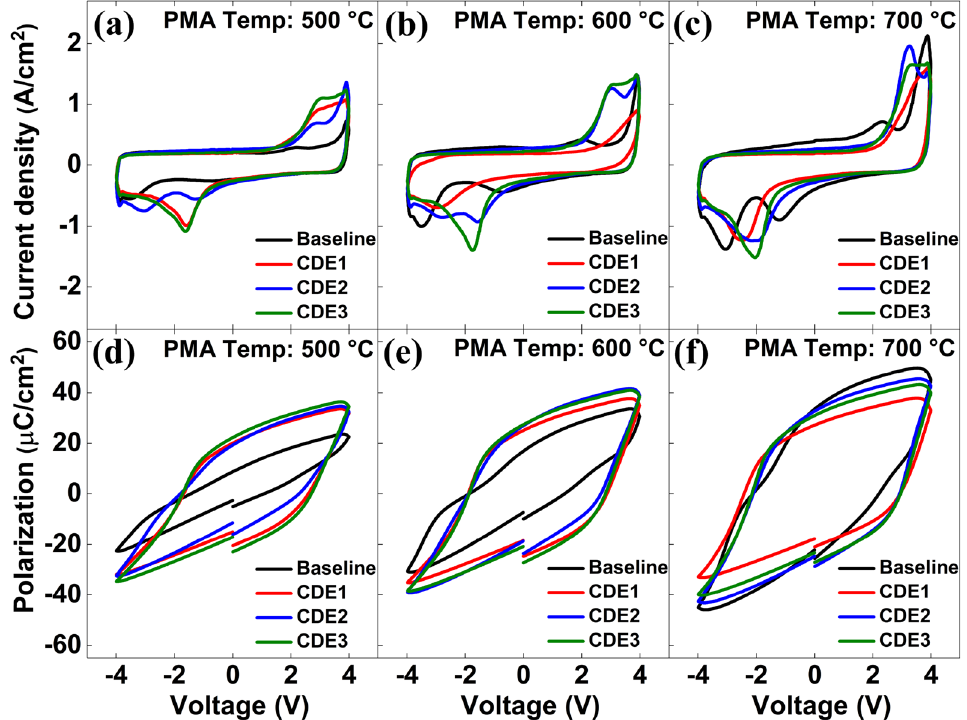
Figure 2. Measured current density versus voltage and pristine polarization versus voltage for three different post metal annealing (PMA) temperatures: ( a,d ) 500 °C, ( b,e ) 600 °C, and ( c,f ) 700 °C. Chemical Dry Etch (CDE) 1, 2, and 3 indicates the passivated samples (Baseline sample was not exposed to the passivation). The O 2 plasma gas flow conditions for CDE1, CDE2, and CDE3 are 30 sccm, 40 sccm, and 60 sccm, respectively. Note that the fluorine plasma gas flow for all the samples was identically set to 80 sccm.